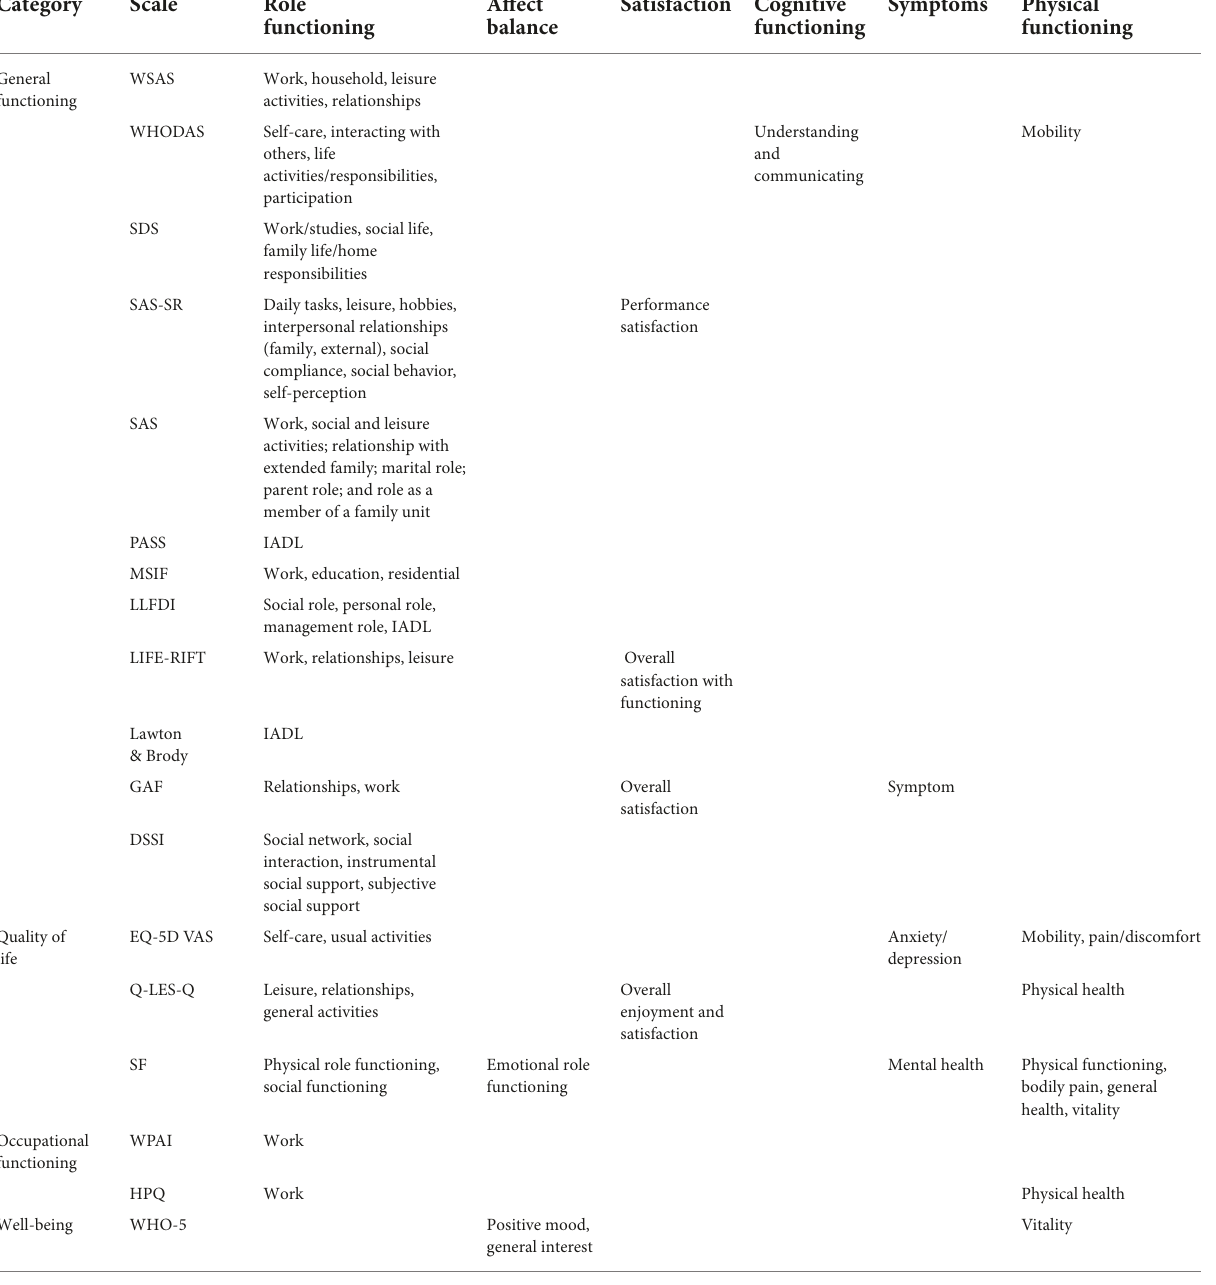
TABLE 3 Dimensional settings of scales commonly used for proxy